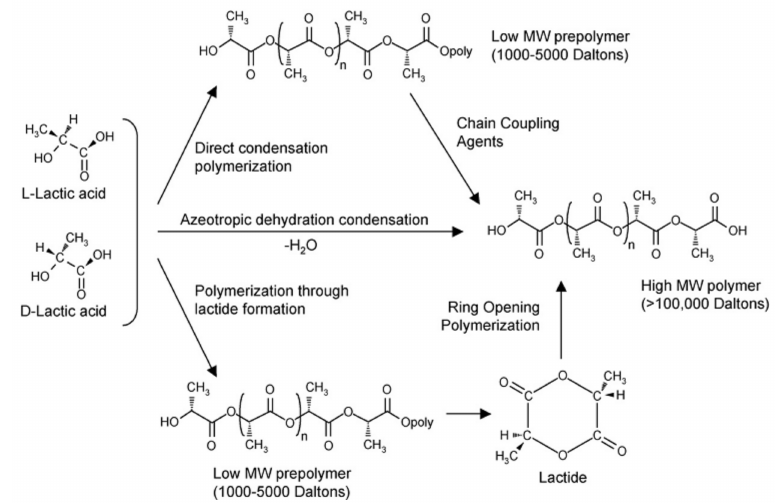
Figure 1. Synthesis of PLA from l- and d-lactic acids. Reproduced with permission from